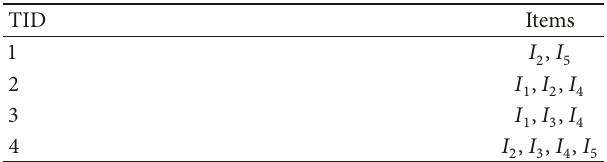
Table 1: A transaction database.